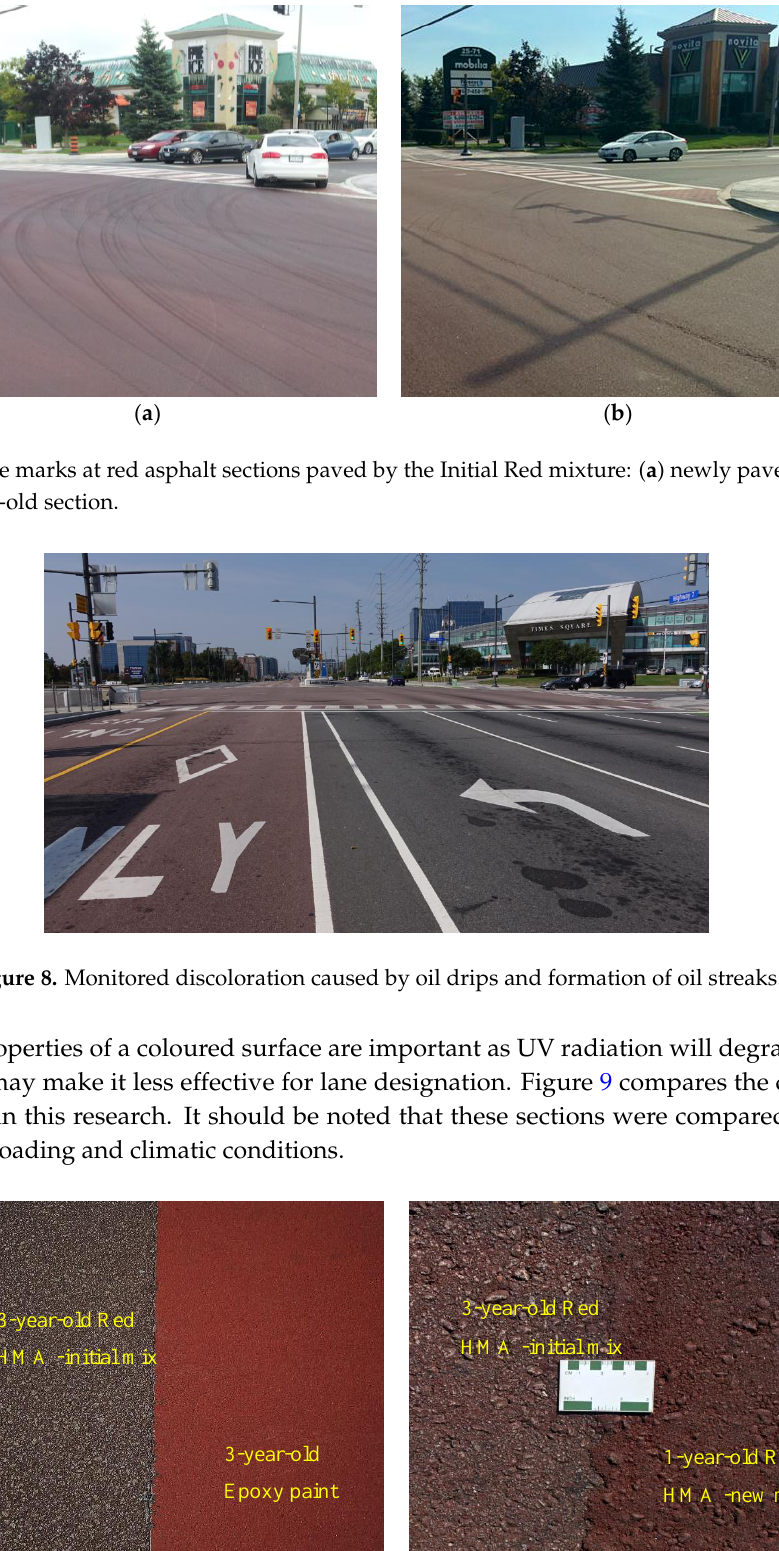
Figure 9. Visualization of tested surfaces: ( a ) Red HMA-initial mix and epoxy paint; ( b ) Red HMA-initial mix and Red HMA-new mix.